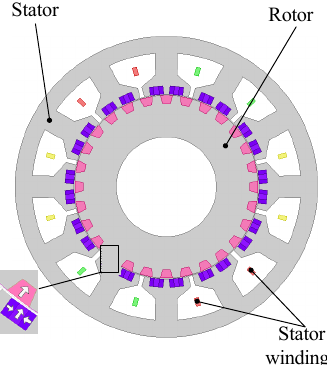
Figure 1. Topology of the proposed machine.